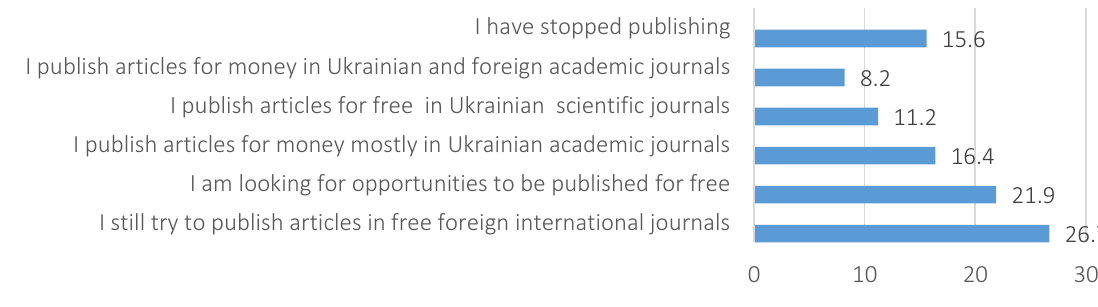
Figure 4. Answers to the question “What are the financial